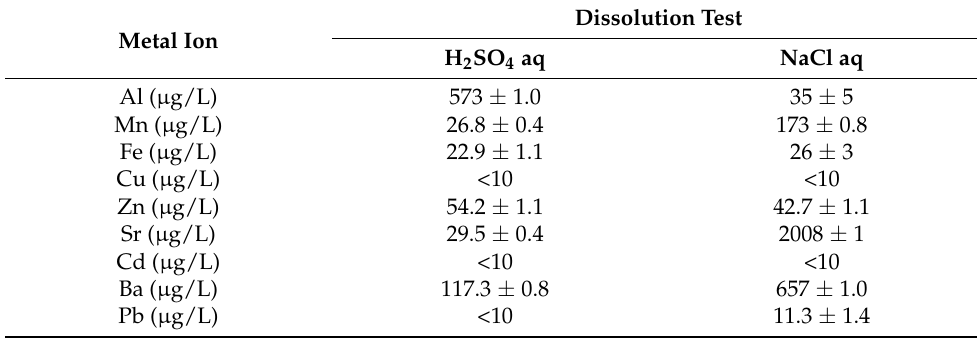
Table 3. Concentrations of metal ions obtained by dissolution tests on cigarette butts.